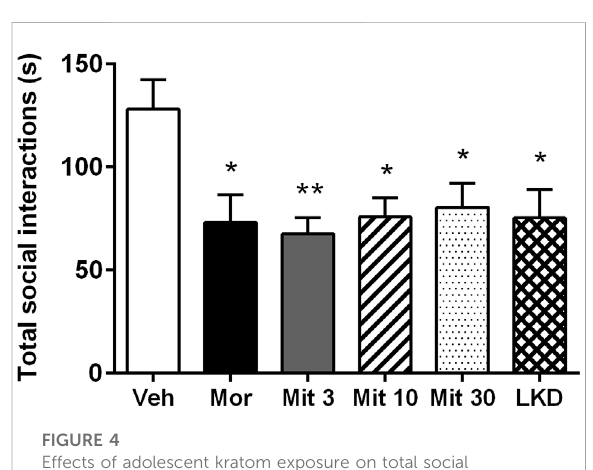
FIGURE 4 Effects of adolescent kratom exposure on total social interaction. Data are expressed as mean ± SEM ( n = 8 – 10). * p < 0.05, ** p < 0.01, vs. vehicle-treated